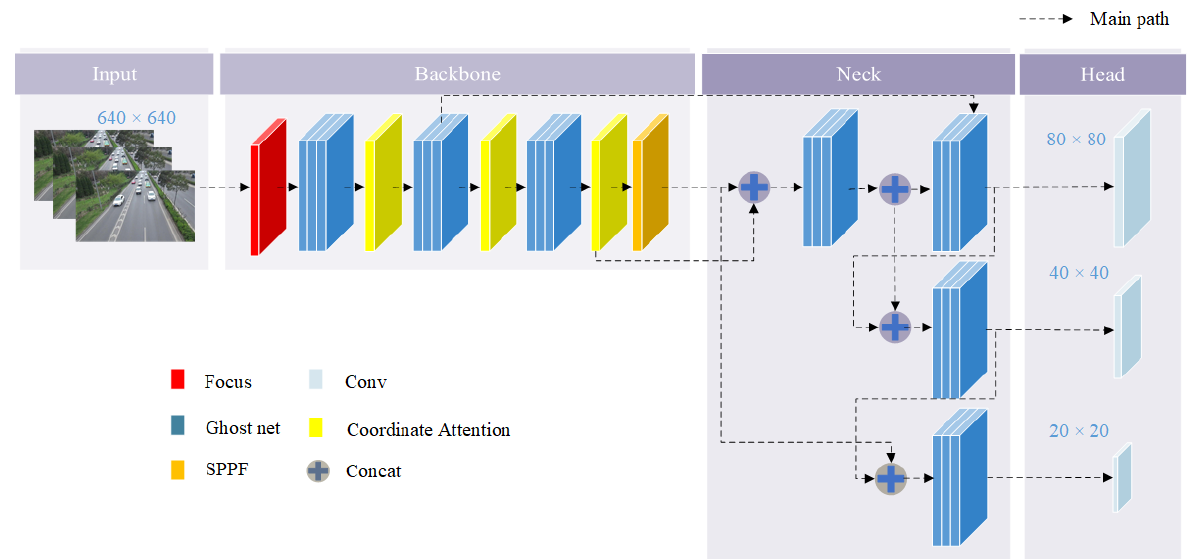
Figure 5. YOLOv5_B network structure.